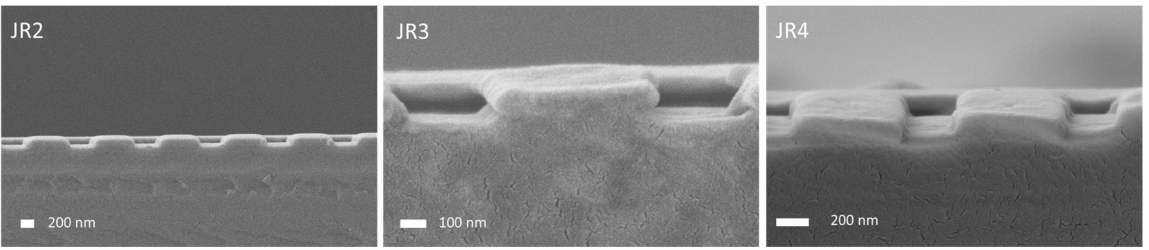
Figure 5. Cross-sectional SEM images of stamps made from different materials. For NILcure ® JR2 and JR4 it can be seen that the undercut is not replicated at all, while for JR3 the undercut is only partly